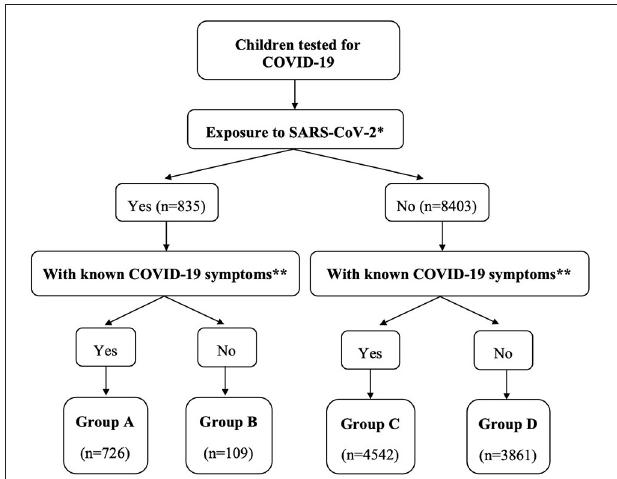
FIGURE 1 | Stratification of enrolled